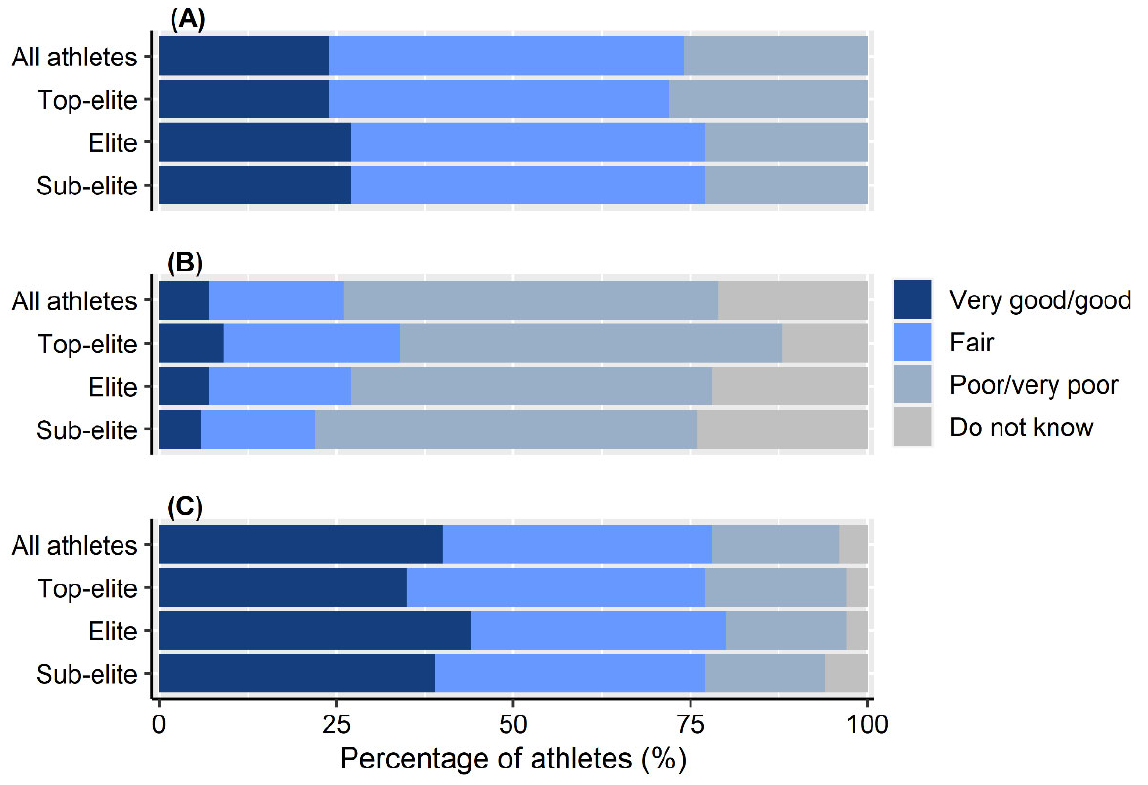
Figure 2. Athletes’ own perceived knowledge about aspects of female athlete health that might influence athletic performance ( A ), their coach’s knowledge in this area ( B ) and whether this subject was taboo in the athletic community ( C ) across athlete level. For “C”, the ordinal scale “ Strongly agree/agree ”, “ Partly agree ”, “ Disagree/strongly disagree ”, “ Do not know ” was used in descending order. Forty percent of the athletes ( n = 433) strongly agreed or agreed that female athlete health is considered a taboo topic in sports (Figure 2). There were no differences across athlete level of athlete knowledge about female athlete health ( p = 0.171), athlete perception of their coach’s knowledge ( p = 0.203) or the proportion of athletes that considered female athlete health to be a taboo topic ( p = 0.434) (Figure 2). Athletes who considered their own knowledge as very good/good were significantly ( p < 0.001) older compared to athletes that rated their knowledge as fair or poor (Figure 3), with small effect sizes for age-group differences (Cohen’s d 0.22–0.29). There was no difference ( p > 0.05) in age between athletes that rated their knowledge as fair compared to poor, the proportion of athletes that perceived female athlete health to be a taboo topic and how the coach’s knowledge was viewed (Cohen’s d